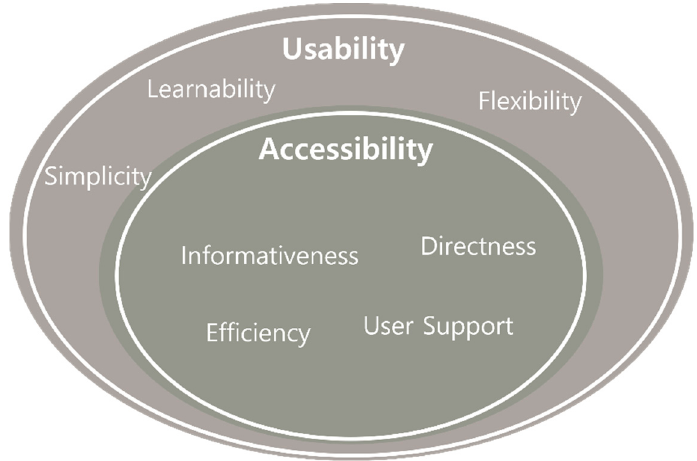
Figure 5. Primary categories of accessibility and usability for kiosks.